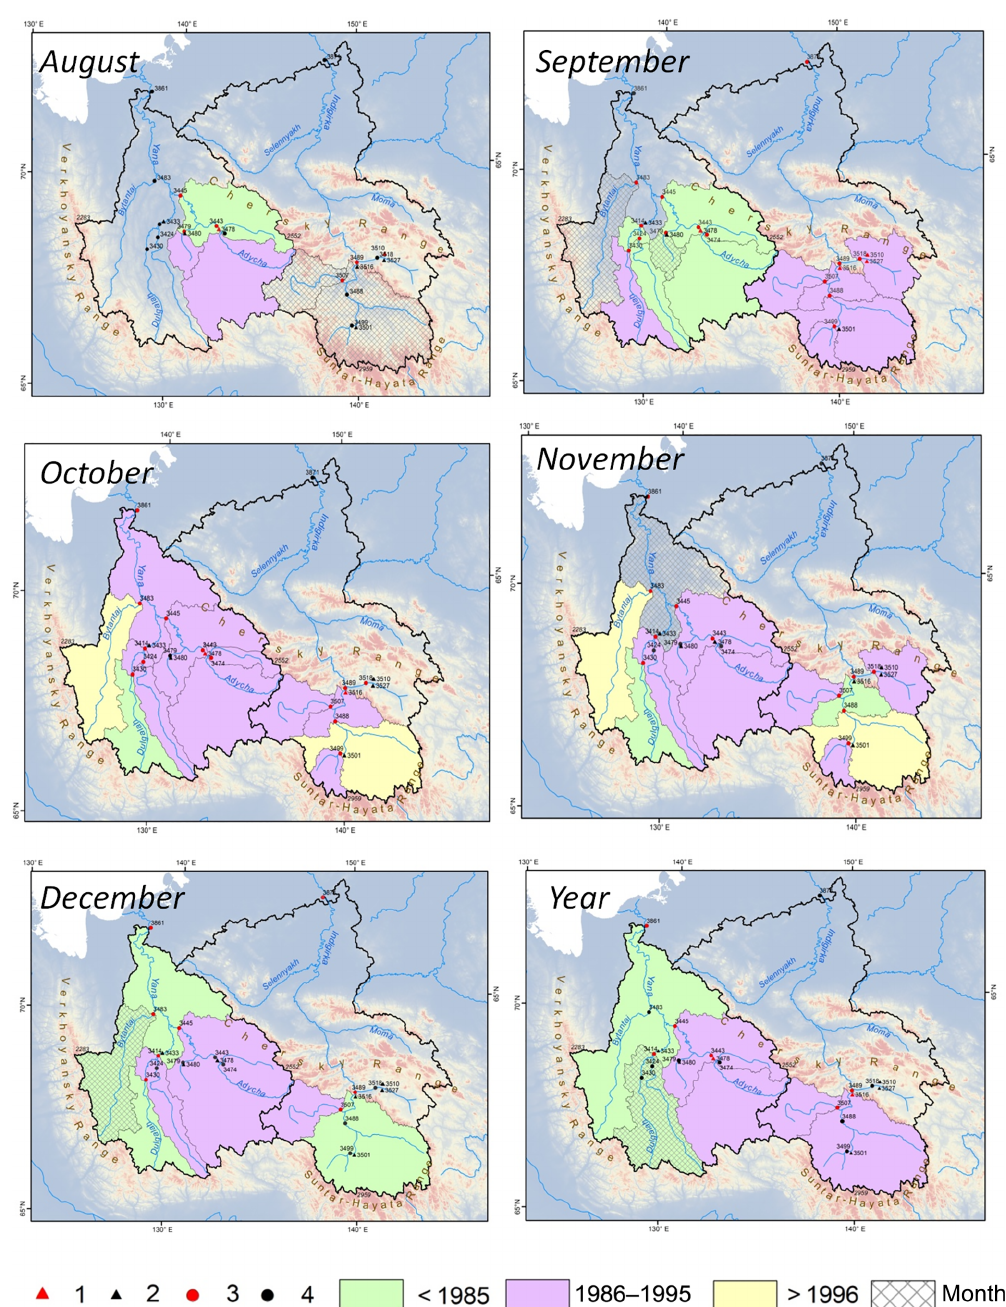
Figure 4. The periods of changes in streamflow in August, September, October, November, December, and annually. Red and black indicate the presence and absence of the trends, respectively. The triangles and circles indicate the basin area of less and more than 1000km 2 , respectively. Detailed figures for each month can be found in Figs.